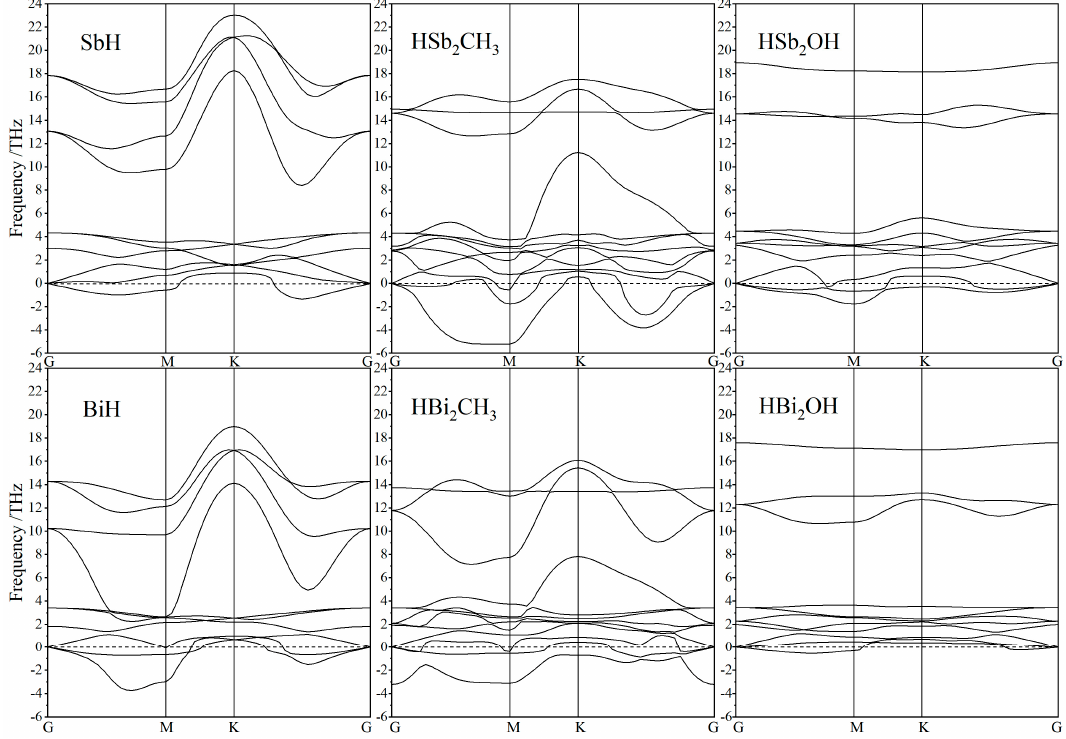
Figure 2. Phonon dispersion spectra of Janus Sb and Bi monolayers in comparison to SbH and BiH monolayers.